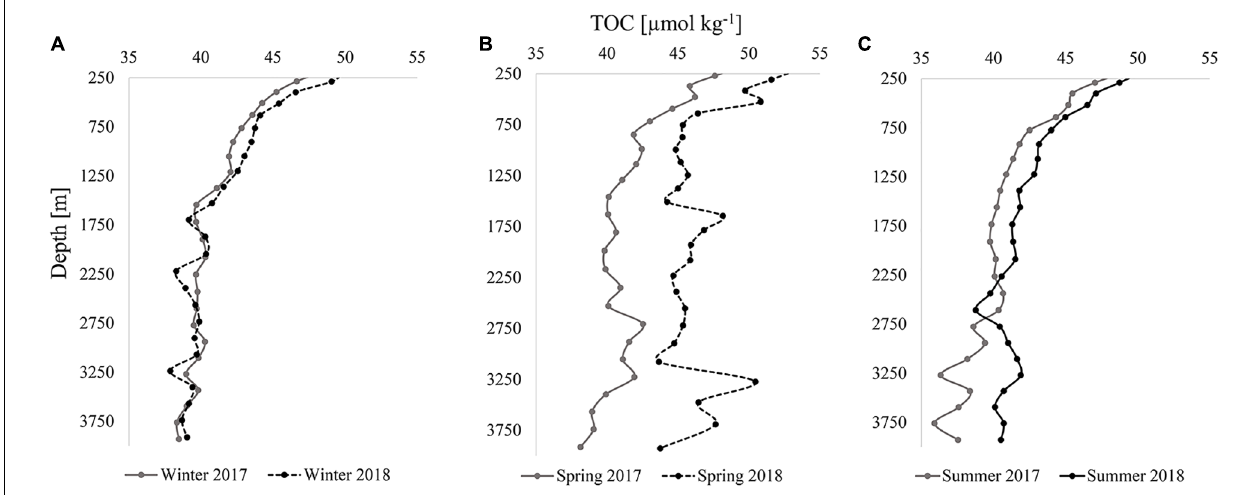
FIGURE 6 | Internannual comparisons (2017 and 2018) of modeled TOC [ µ mol kg − 1 ] vertical profiles for all stations in the analysis in winter (A) , spring (B) , and summer (C) .